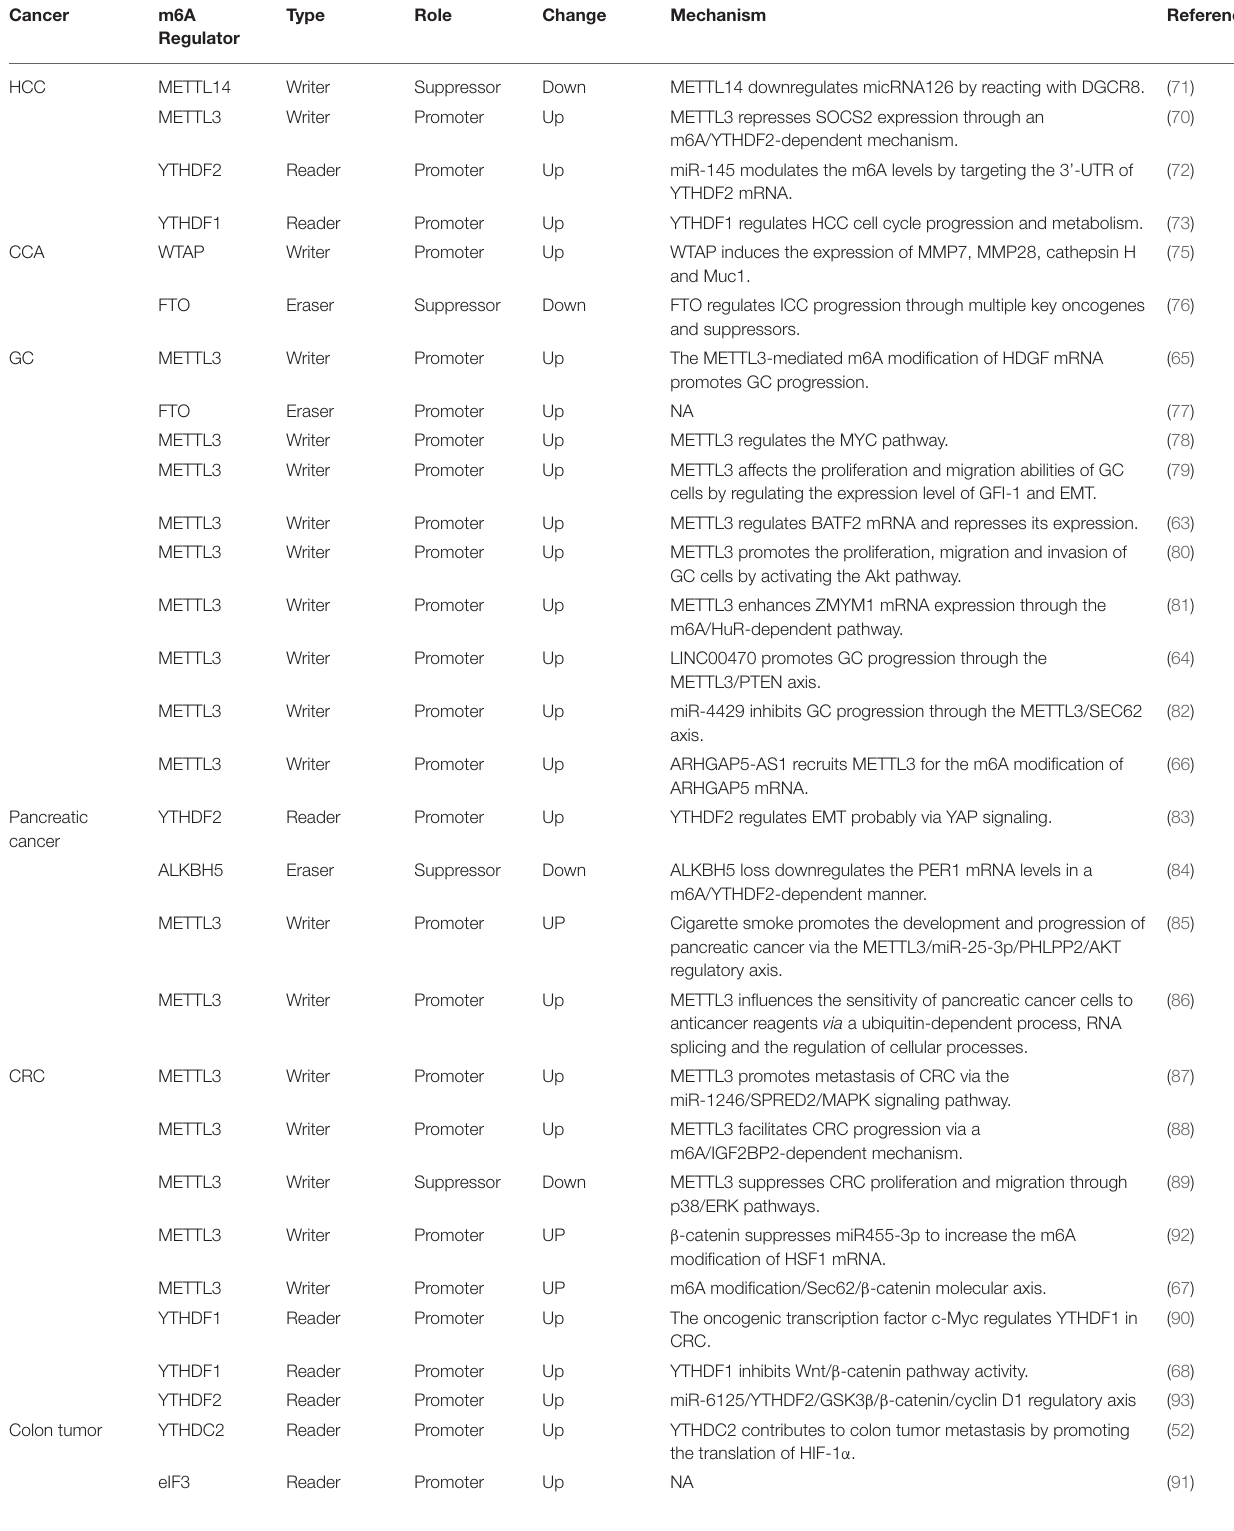
TABLE 1 | The roles and mechanisms of the m6A modification in digestive system tumors.